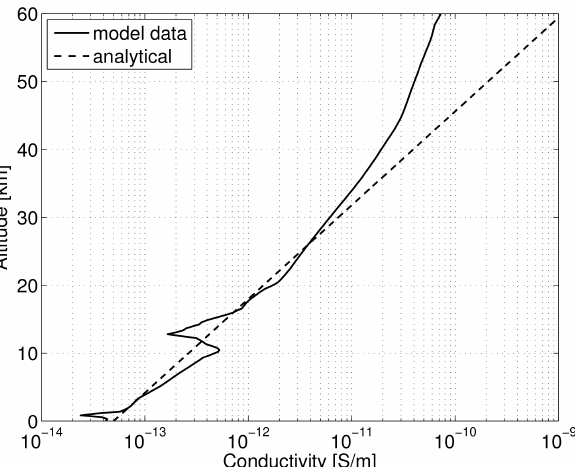
Figure 9. Analytical–exponential conductivity used in Sect. 6 com- pared to an example of the conductivity from WACCM model out- put with clouds and aerosols at 0 ◦ latitude and 180 ◦